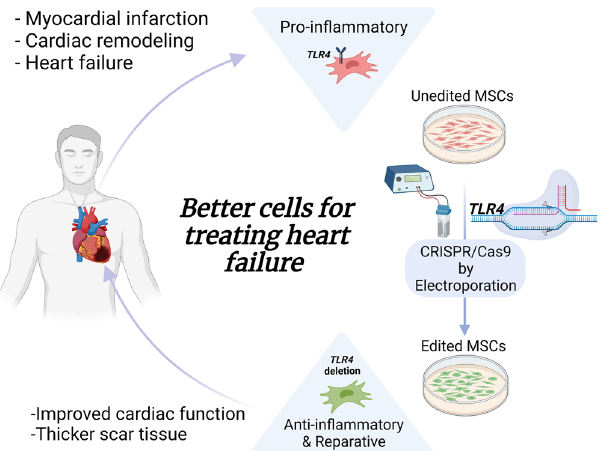
Figure 7. Graphical abstract: genome editing to improve the outcome of cardiac cell therapy. Schematic description of the use of genome editing to improve the outcome of cardiac cell therapy. TLR4 disruption can improve the reparative properties of autologous hMSCs in patients with heart disease. Created with BioRender.